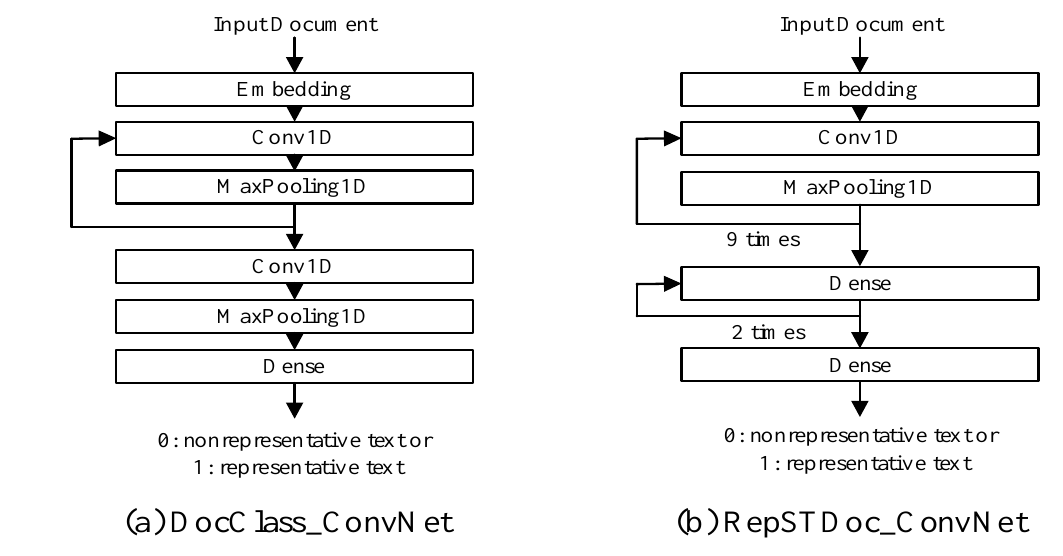
Figure 2. A comparison of DocClass_ConvNet [22] and RepSTDoc ConvNet.